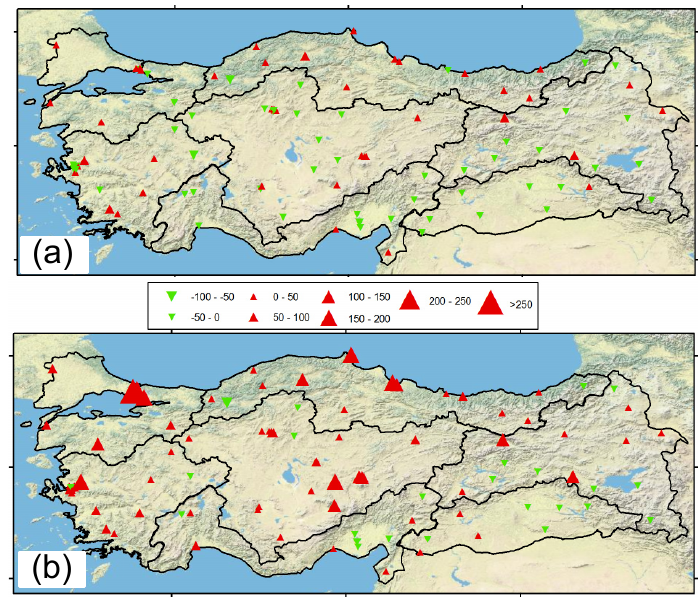
Figure 3. Anomaly values of the ( a ) March 23, 2016 and ( b ) March 24, 2016 daily PM 10 observations ( μ g·m − 3 ) of the stations when compared with its long-term spring mean PM 10 values. On 24 March 2016, the higher daily PM 10 values were recorded at many stations of the country (Table 1 and Figure 3b). In this day, 74% of all stations show above-normal daily PM 10 concentrations. In the regional perspective, all stations located in MR present higher daily PM 10 anomalies, and followed by CAR (90%), AR (88%), and BSR (87%) regions, respectively. When compared with measurements from the previous day, daily PM 10 values for certain stations turned from negative to positive anomalies over MR, AR and BSR; maximum positive variation was observed in the central part of the Anatolian Peninsula. It has also been shown that only the limited